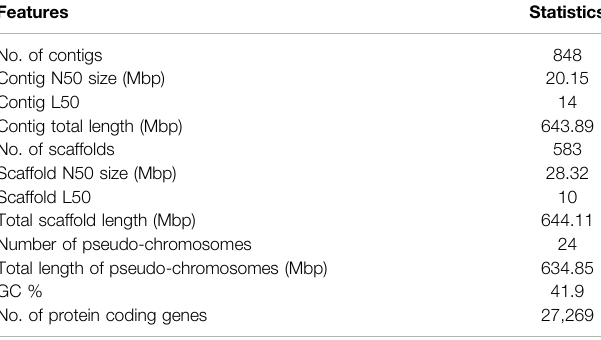
TABLE 1 | Summary of Mugil cephalus genome assembly and